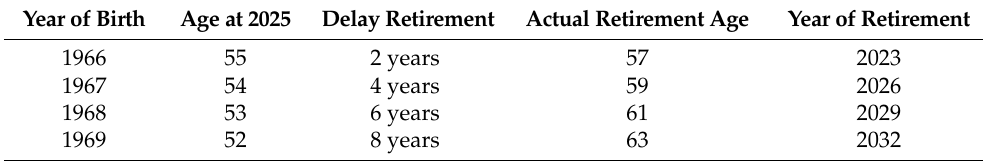
Table 11. Delayed retirement plan II (female staff).